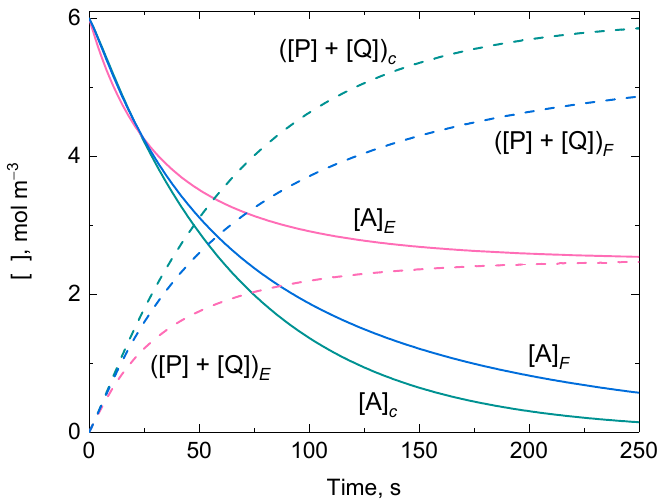
Figure 5. Representative numerically integrated solutions of the time-dependent variation of the concentration for the substrate A undergoing disproportionation, and the sum of products P and Q of an enzyme-catalyzed ping-pong reaction in which suicide substrate inactivation by A occurs when the enzyme is in the active state E (subscript E ) or F (subscript F ). The subscript c stands for control. Initial conditions = 6 mol · m − 3 , [ E ] = 1 mol · m − 3 , k a = 10 − 2 m 3 ( mol · s ) − 1 , k d = 3 × 10 − 2 m 3 · ( mol · s ) − 1 , and k i = 8 × 10 − 3 m 3 · ( mol · s ) − 1 . The value for k i was the same regardless of which enzyme state reacted with the suicide